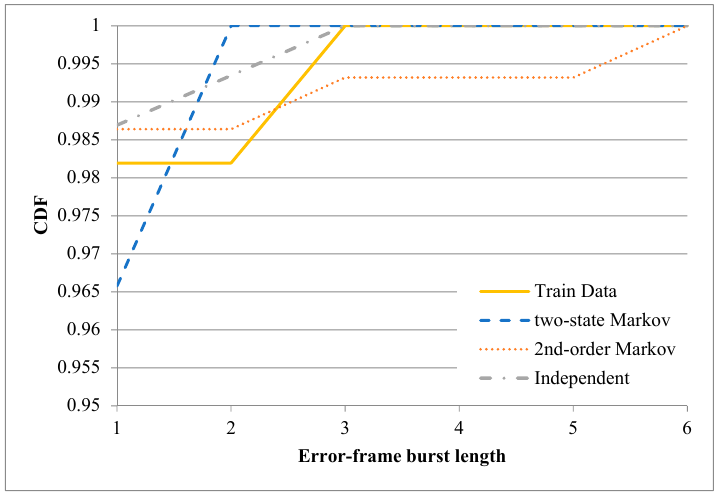
Figure 13. CDFs of error-frame burst length derived using different error models based on recorded trace in the first minute of the sixth hour.